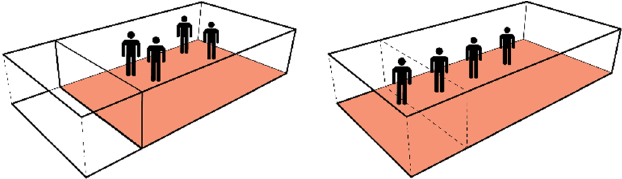
Figure 23. Diagrammatic representation of the intermediate space coupled with the